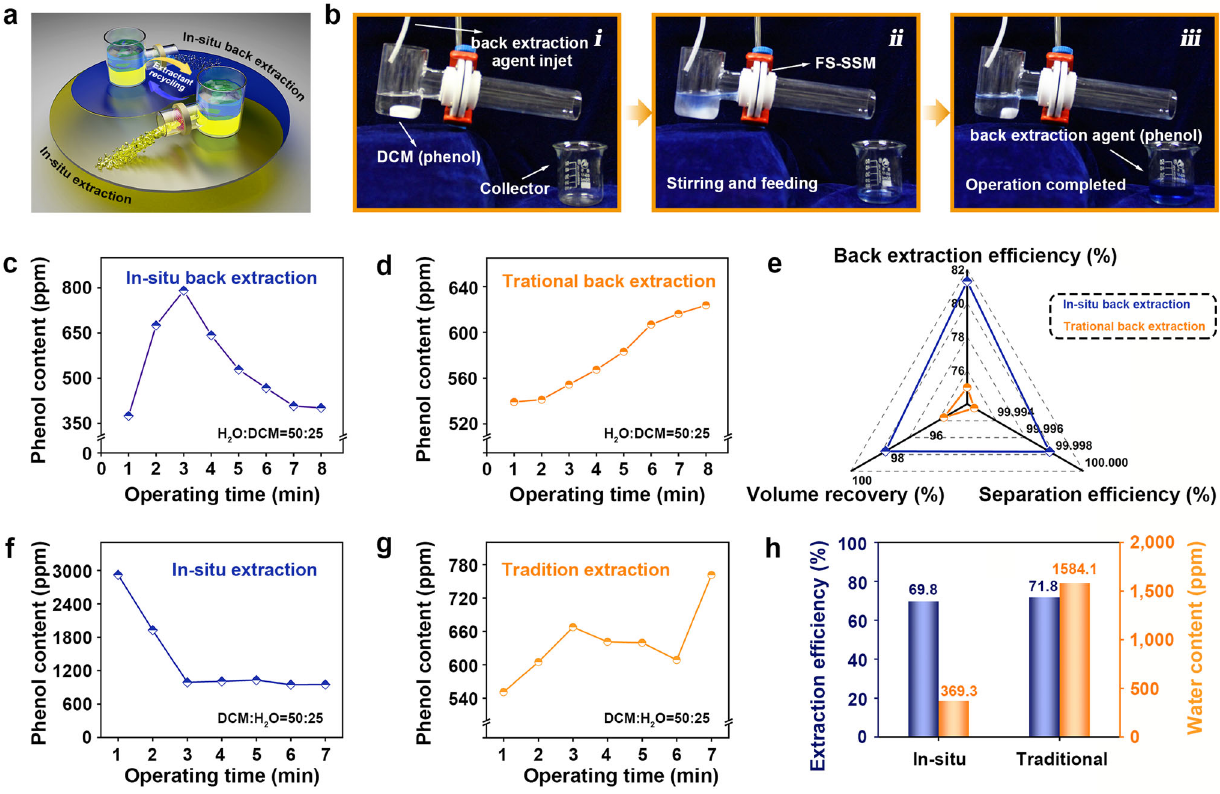
Fig. 5 In situ extraction/back extraction using the recon fi gurable membrane. a Schematic illustration of the extraction-back extraction coupling and recycling process. b Digital photographs of the in situ back extraction process based on FS-SSM (i – iii). Real-time concentration of phenol in the back extraction agent phase during c the in situ back extraction process and d the traditional route. e Evaluation to back extraction performances of two methods from three different evaluation perspectives containing back extraction ef fi ciency, volume recovery of the back extraction agent, and separation ef fi ciency. Real-time concentration of phenol in the extraction agent phase during f the in situ extraction process and g the traditional route. h Extraction ef fi ciency and water content in the collected extraction agent of the in situ extraction and traditional